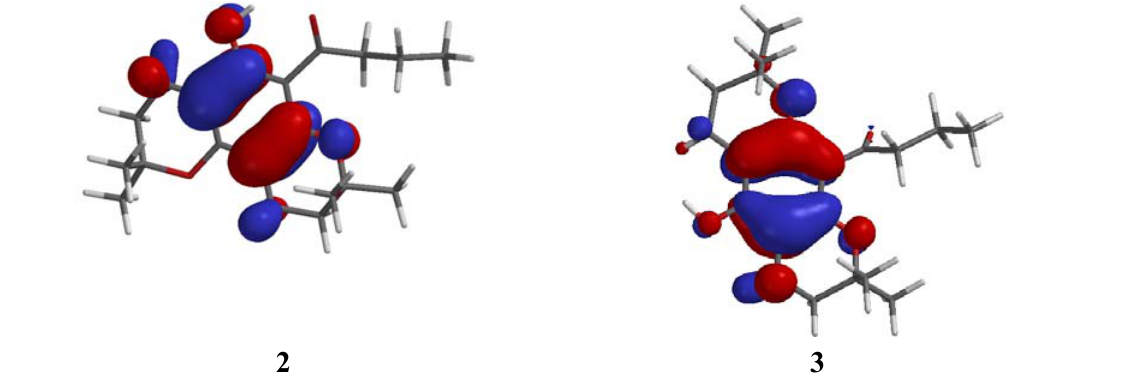
Figure 4 . Orbital representation of the HOMO energies of 2 and 3